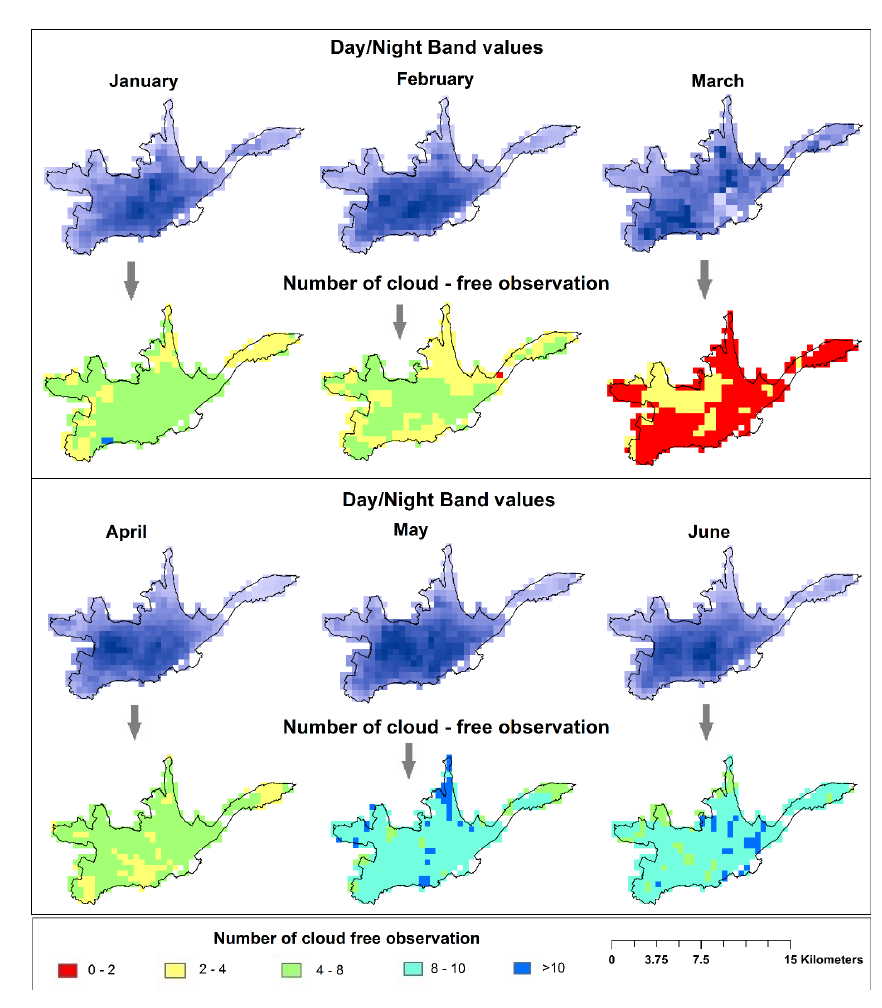
Figure 9. VIIRS data of the first six months of 2015 for the Cuenca City study area. Grids of average light intensity ( top ). Grids showing the number of cloud-free observations at the cell level used to produce the average light intensity composites ( bottom ).